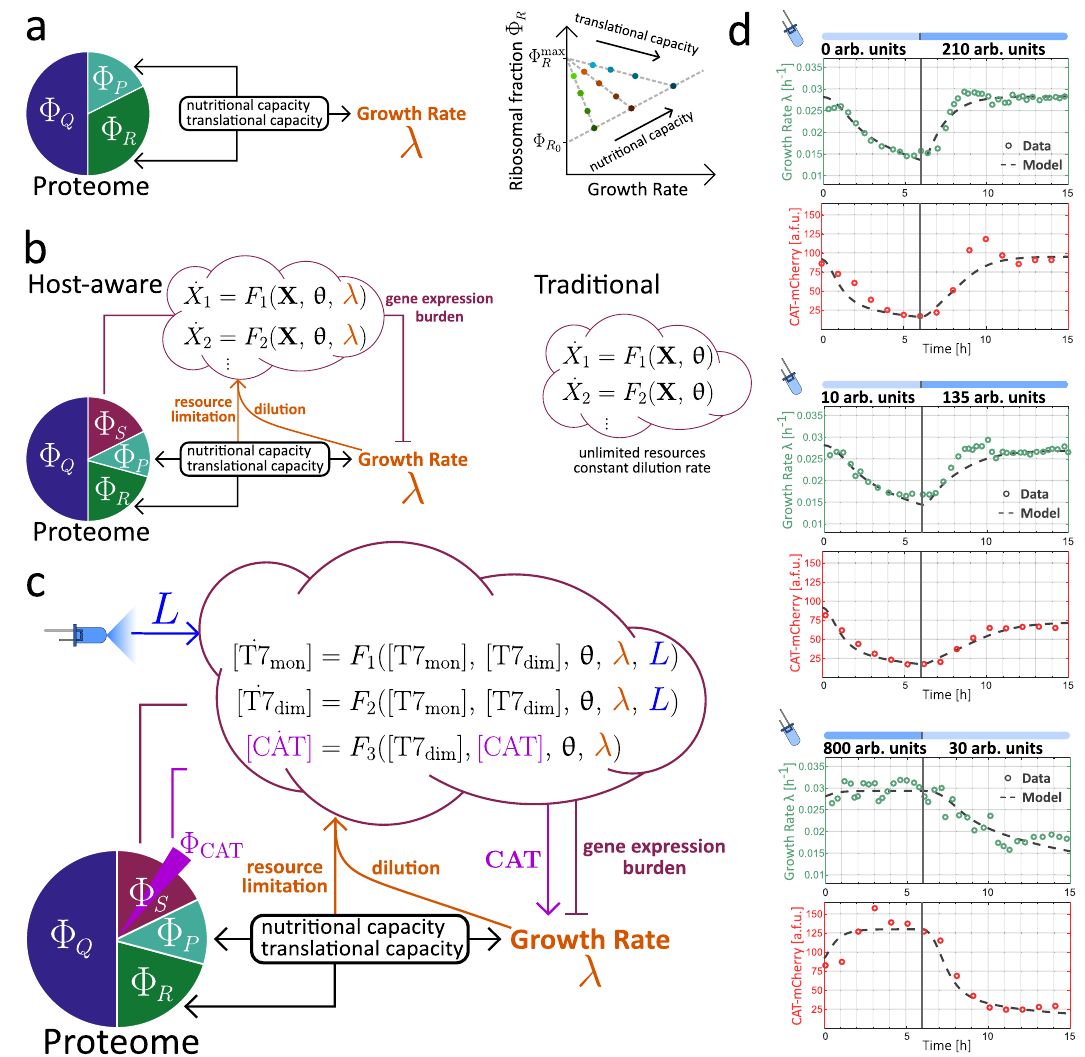
Fig. 4 | Host-aware modeling framework appliedto the photophilic strain. a In proteome-partition models, empirical correlations between growth rate and ribo- somal mass fraction arise from a balance between co-regulated sectors of the proteome: a fi xed, house-keeping fraction ( Φ Q ) and two fl exible sectors, the ribo- somalfraction( Φ R )andthecatabolicfraction( Φ P ).Thegive-and-takeregulationof the latter two sectorsdetermines the cellular growth rate, mediating adaptationto environmental conditions characterized by nutrient quality and translational capacity. Figure adapted from refs. 47 and 54. b In our approach to host-aware modeling, the dynamics of arbitrary synthetic genetic circuits, described by a systemofODEs,areembeddedintoaproteome-partitionframeworkthatcaptures thephysiologicalresponseofthecell.IncontrasttoatraditionalODEmodel,which does not consider the physiological adaptation of the host's growth rate, gene-